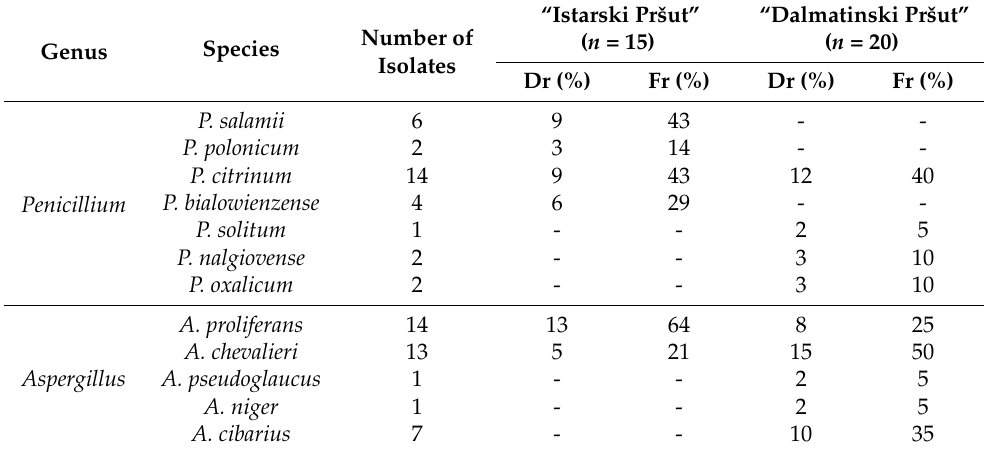
Table 2. Surface mycobiota found on “Istarski pršut” and “Dalmatinski pršut”. Genus Species